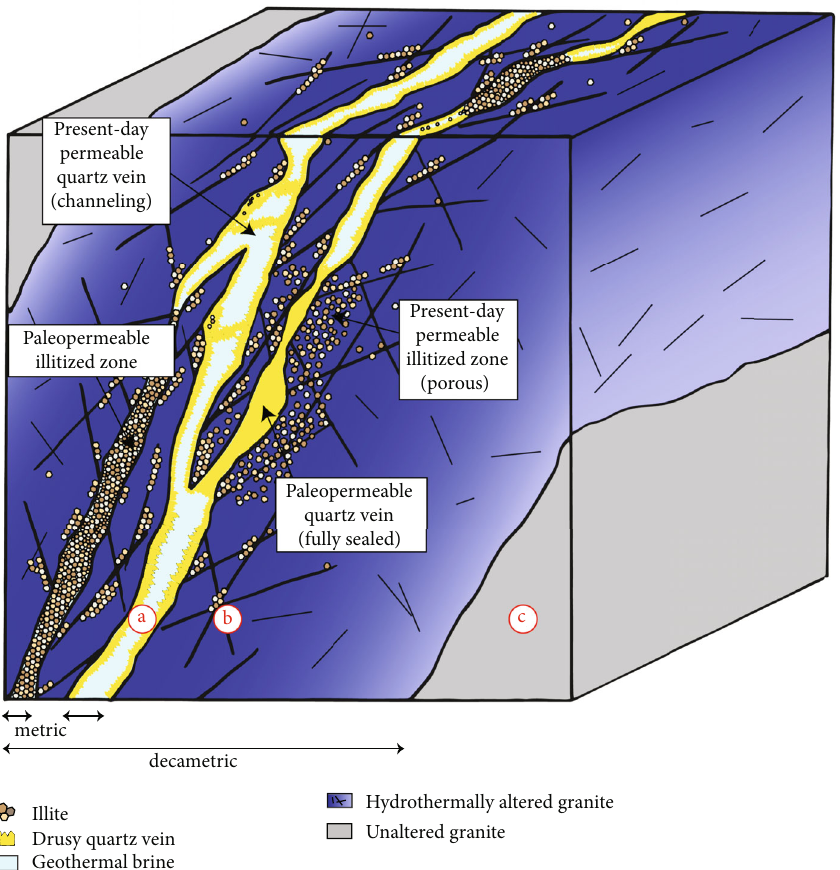
Figure 1: Complexity of a FZ after Caine et al. [71]. We can di ff erentiate three zones: (a) the fault core, which can be a pathway for fl uid if illite and quartz veins are not totally sealing the zone, (b) the damage zone, which can be sealed or opened with fractures that are acting as fl uid pathways, and (c) the unaltered granite, which shows generally very low